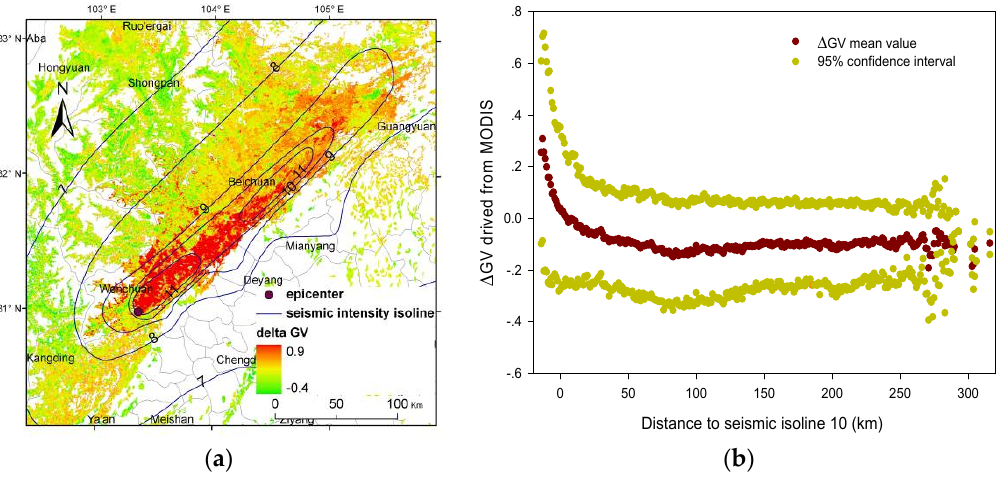
Figure 7. MODIS-derived Δ GV ( a ); and the relationship between MODIS-derived Δ GV and distance away from Seismic Intensity Isoline 10 ( b ). Positive Δ GV represents forest loss, whereas negative indicates intact or improved forest conditions. A negative distance in ( b ) indicates pixels that were located within the seismic intensity isoline, i.e. , the seismic intensity of these pixels was greater than 10.